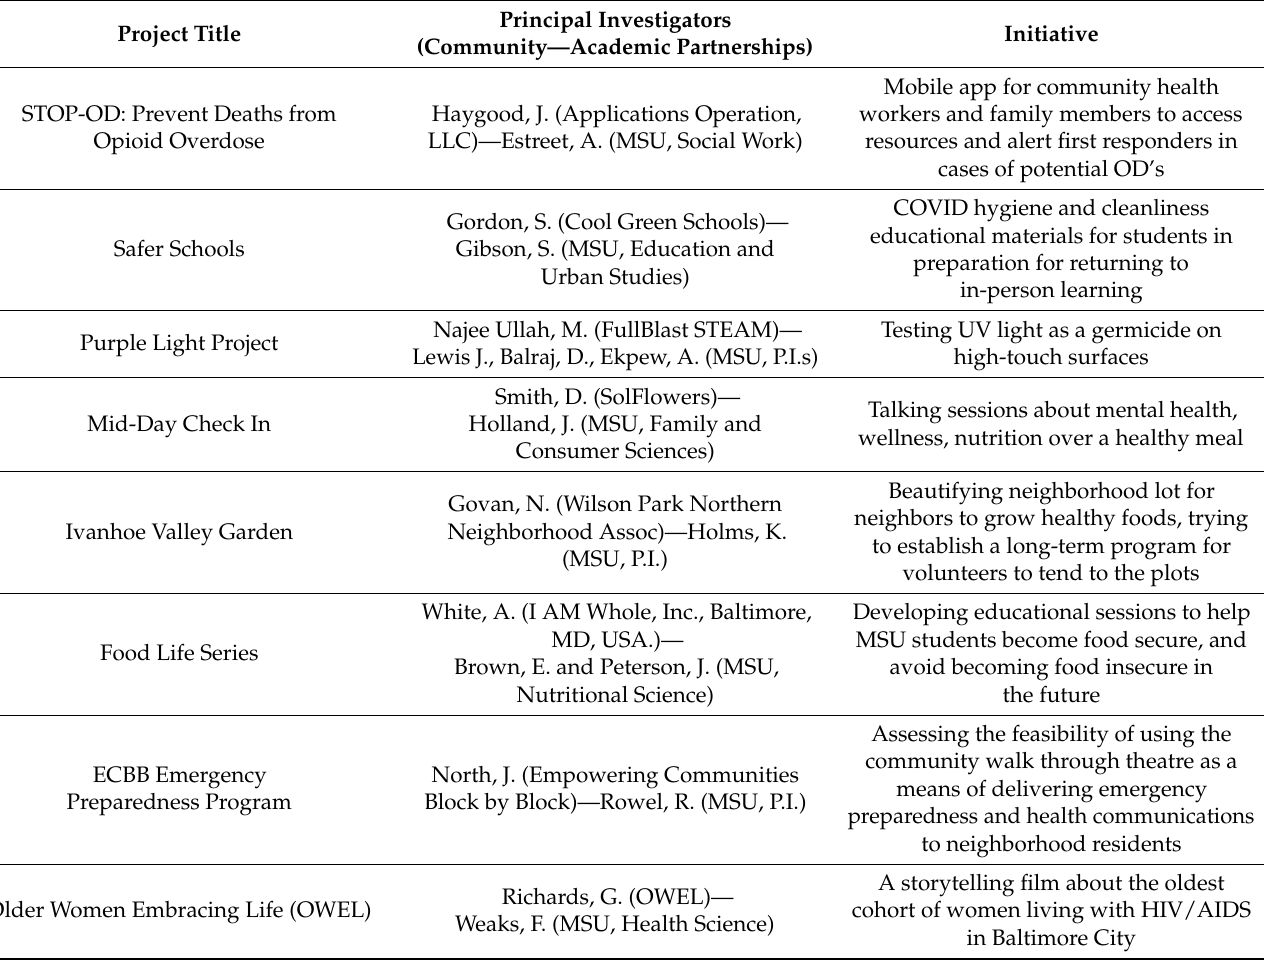
Table 4. Summary of Community Campus Award